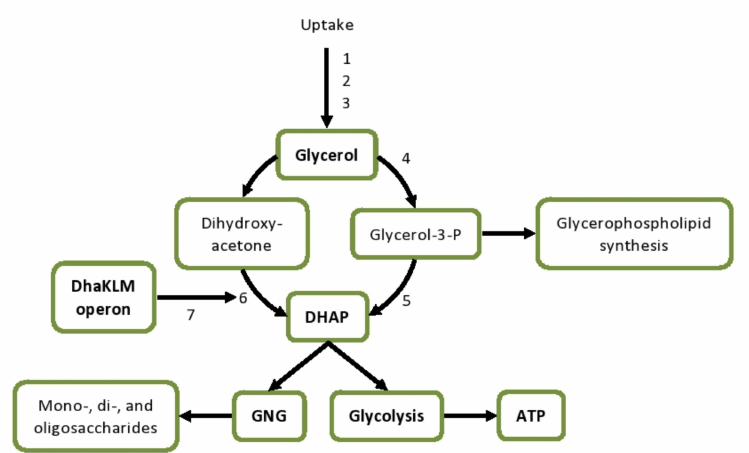
Figure 7. Glycerol uptake and metabolism in L. plantarum Ym1 and 8-1 under butanol stress. DEGs encode the following enzymes, transport proteins, and transcription factors: 1–3, uptake facilitator proteins; 4, glycerol kinase; 5, glycerol 3-phosphate oxidase; 6, PTS-dependent DHA kinase; 7, DhaQ coactivator of the DhaKLM operon. Abbreviations: DEGs, differentially expressed genes, ATP, adenosine triphosphate;